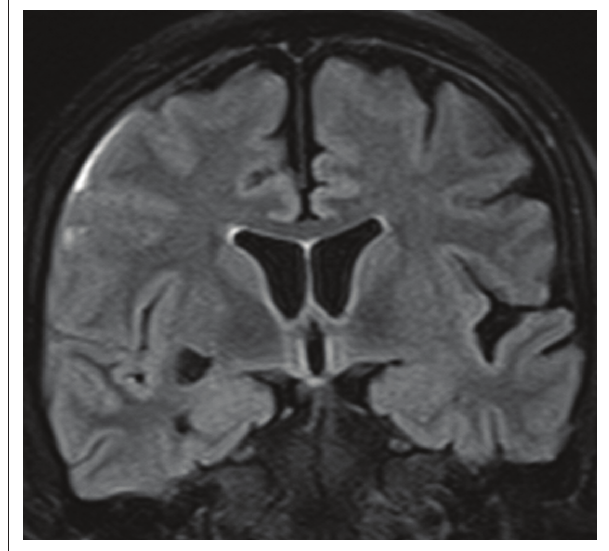
FIGURE 7: Coronal FLAIR MRI